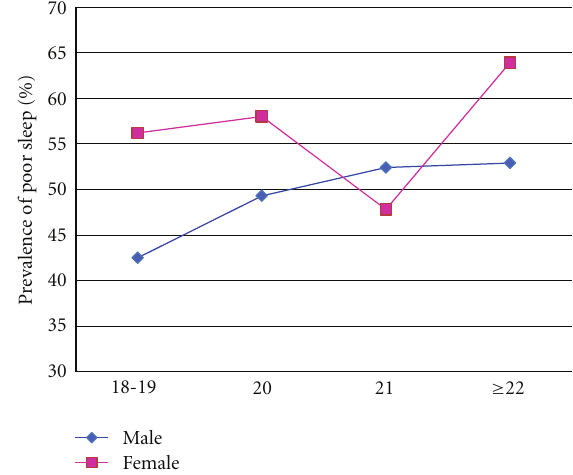
Figure 4: Any ca ff eine containing beverages consumption by age and